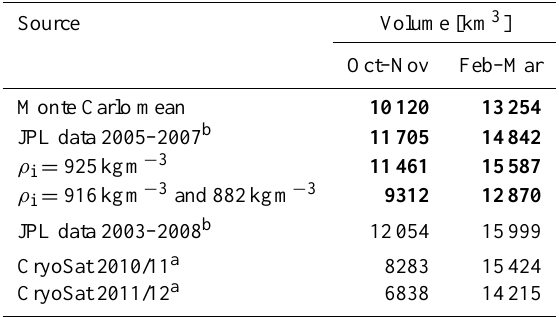
Table 5. Sea ice volume as calculated in this study using different assumptions about the density in comparison with previous publi- cations. Values that are calculated in this study are marked in bold. Same values are given in Fig.